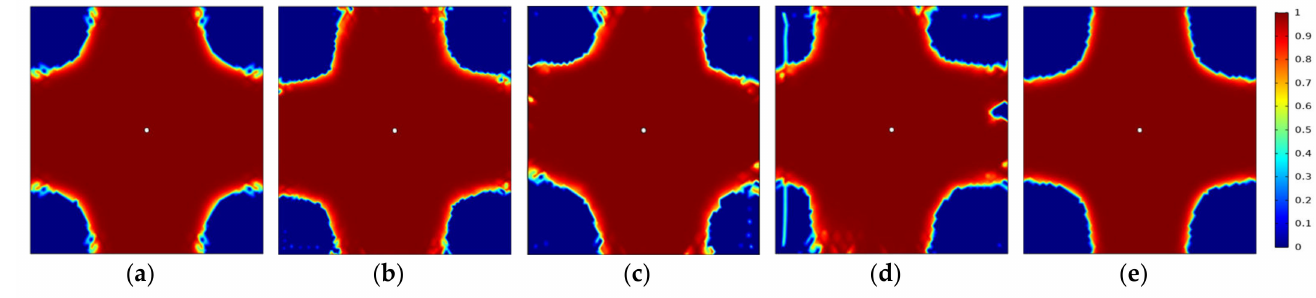
Figure 8. Coal rock tensile damage D . ( a ) m = 0; ( b ) m = 0.5; ( c ) m = 0.8; ( d ) m = 1.1; ( e ) m = ∞ .